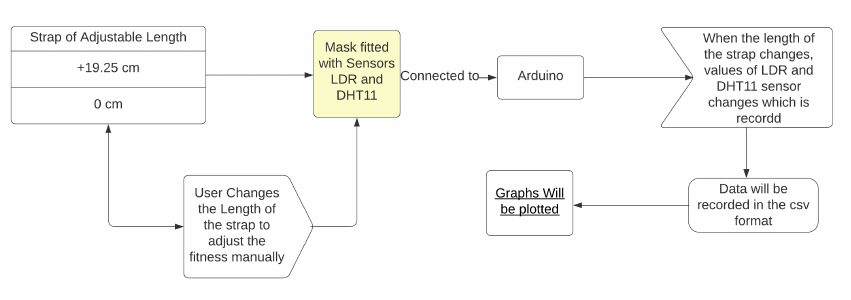
Figure 10. Design and plotting of data.